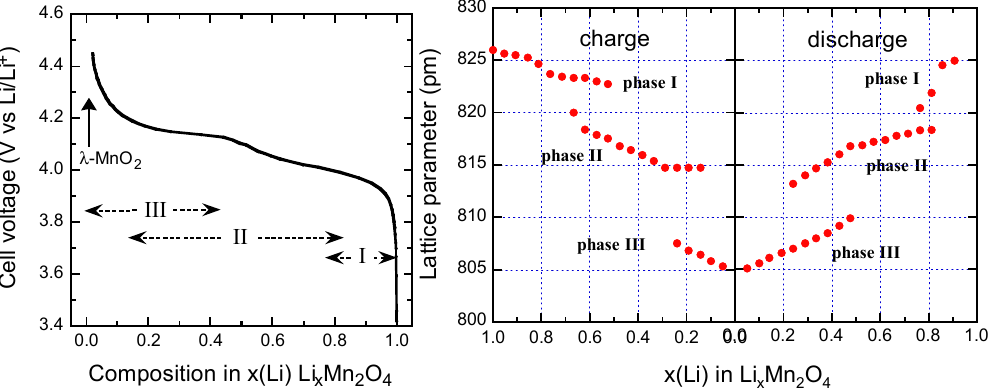
Figure 5. Voltage profile of a Li//LiMn synthesized at 700 °C ( left ).Variation of the lattice parameters as a function of the Li content x during the charge/discharge in LMO cathode ( right